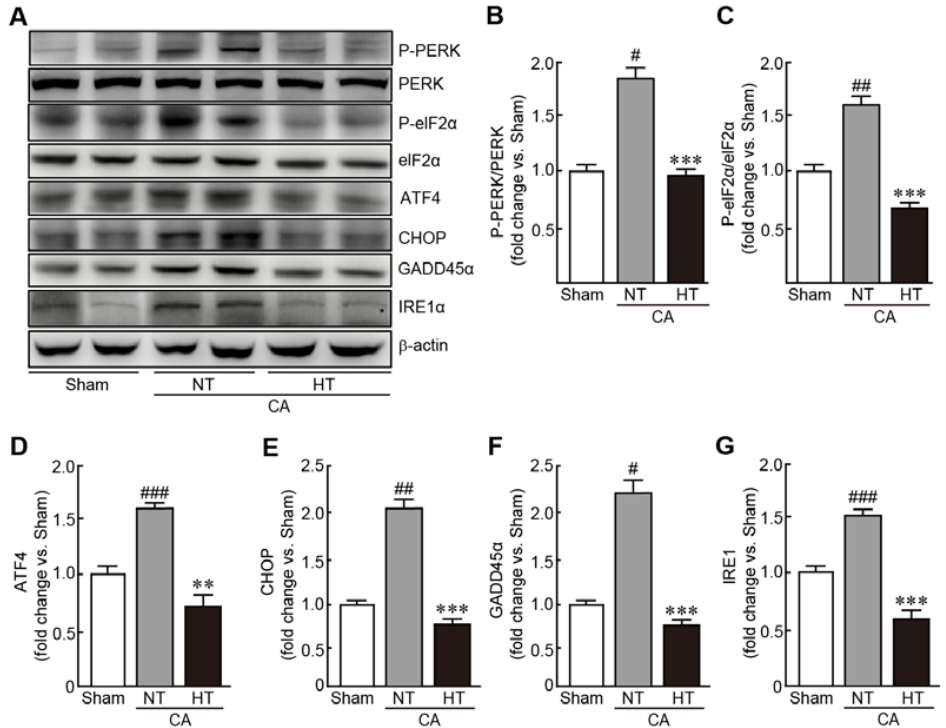
Figure 7. Olanzapine-induced TH inhibits CA-induced ER stress in renal tissues. ( A – G ) Western blot analysis for measuring the expression levels of ER stress signaling-related proteins in rat tissues after CA and ROSC with or without olanzapine-induced TH ( n = 3 per group). Significance is represented as # p < 0.05, ## p < 0.01, and ### p < 0.001 vs. the sham group; ** p < 0.01 and *** p < 0.001 vs. the CA + NT group. CA, cardiac arrest; TH, therapeutic hypothermia; NT, normothermia; HT, hypothermia.